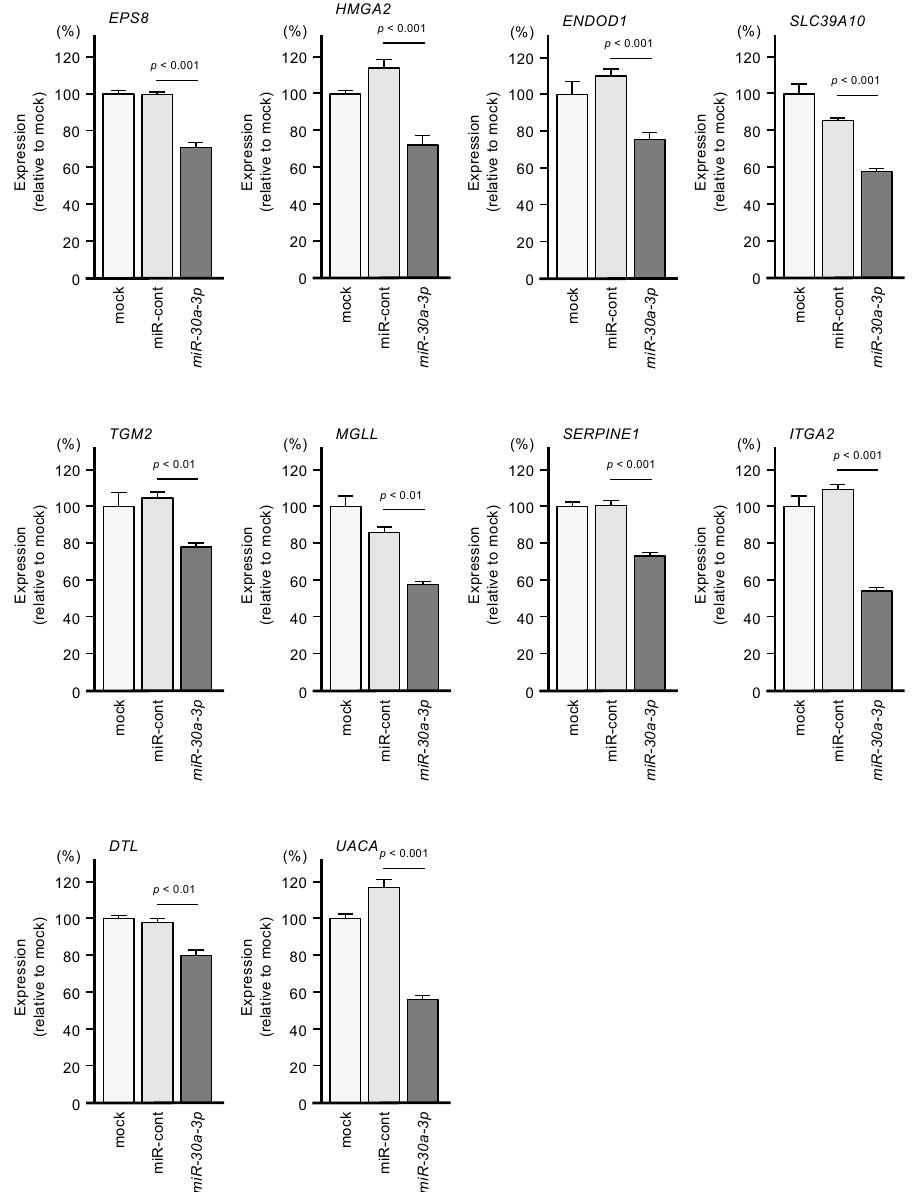
Figure 5. Regulation of the expression of the 10 target genes following transfection of PANC-1 cells with miR-30a-3p.